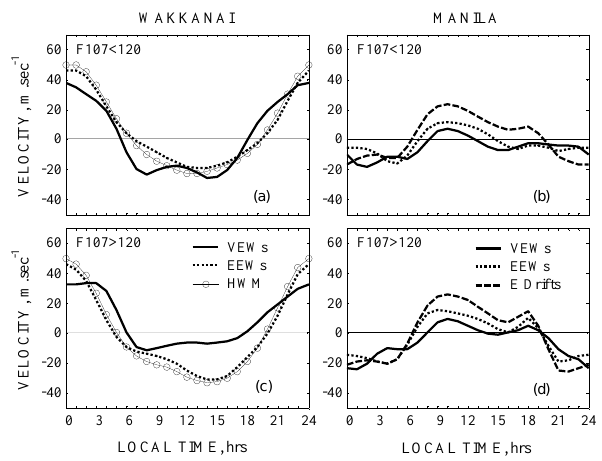
Fig. 6. The diurnal variations of VEWs (solid line) and some related components at Wakkanai (139.5ºE, 35.7ºN, Magnetic 35.4ºN) and Manila (121.1ºE, 14.7ºN, Magnetic 3.5ºN) during March equinox. (a) and (c): during solar minimum and maximum years at Wakkanai, respectively. (b) and (d): during solar minimum and maximum years at Manila, respectively. E Drifts (dashed line) and HWM (solid line with circles) note the vertical components of empirical electric field drifts and of meridional winds, respectively. EEWs (dotted line) notes the combination of E Drifts and HWM , namely empirical equivalent winds. The electric field drifts are estimated from the model of Scherliess and Fejer (1999) and the neutral meridional winds are from the HWM93 model (Hedin et al., 1996). Positive upward.